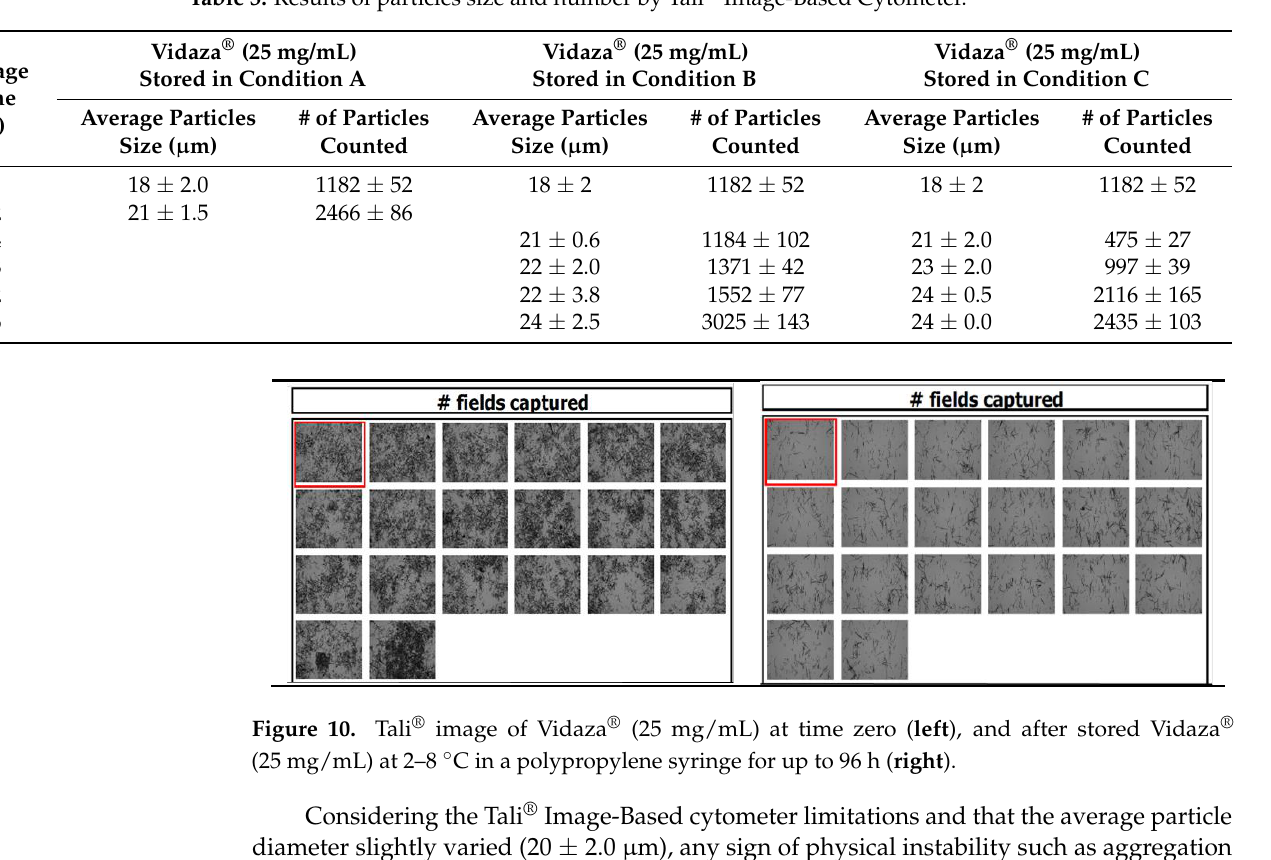
Figure 9. Morphology of Azacitidine crystals at time zero ( a ), and after stored Vidaza ® (25 mg/mL) at 2 – 8 °C in a polypropylene syringe for up to 96 h ( b ). Table 3. Results of particles size and number by Tali ® Image-Based Cytometer.